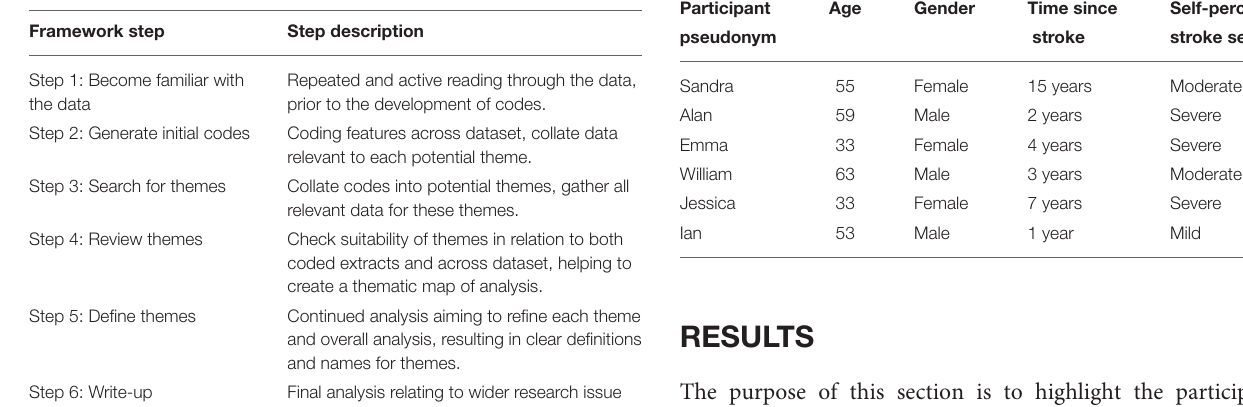
TABLE 2 | Braun and Clarke’s six-step framework for conducting thematic analysis (57).